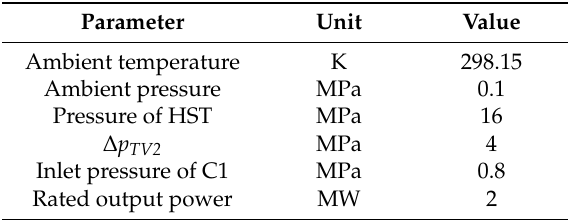
Table 2. Design parameters of the developed CCHP